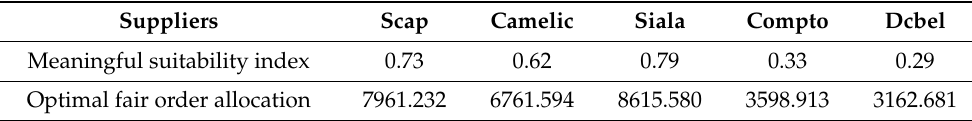
Table 9. The Optimal Fair Order Allocation without the Cutoff Method.